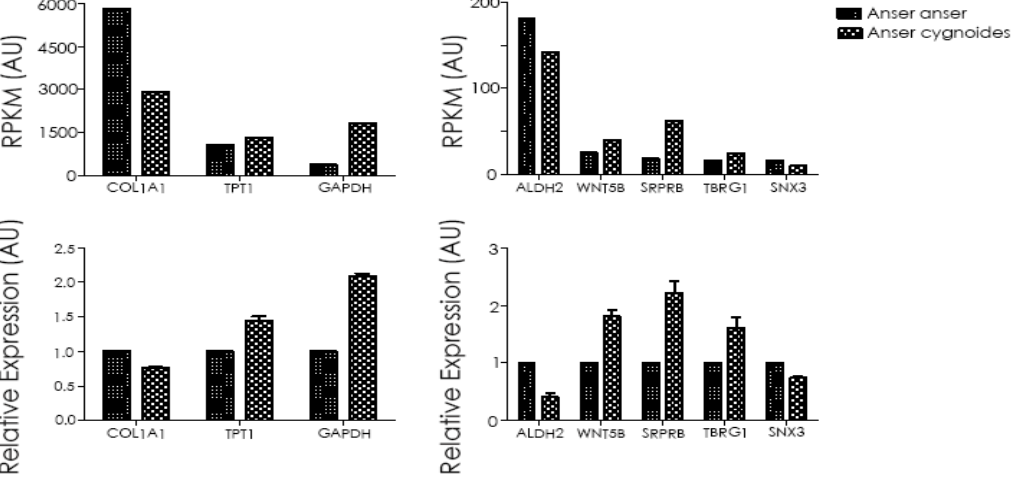
Figure 7. RNA-Seq data reliability check by RT-qPCR. Panel A indicates the RNA-Seq expression level (RPKM) defined as the False Discovery Rate (FDR) < 0.05 and | log2 Fold Change | > 1 and panel B represents the mRNA expression level calculated as the 2 − ∆∆ Ct method of the selected